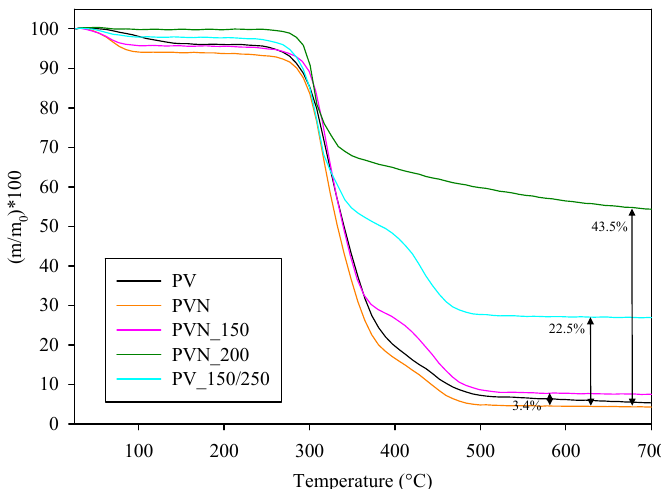
Figure 4. Weight loss with temperature of PVOH polymer (PV), electrospun nanofibers (PVN) and nanofibers coated at different temperatures with their corresponding %TiO 2 deposited.